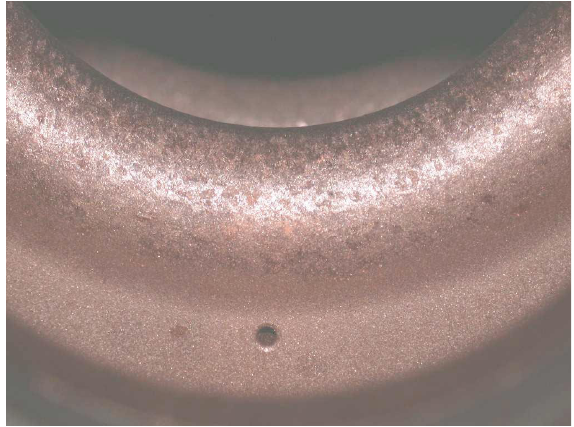
FIG. 23. (Color) Damage on the irises.